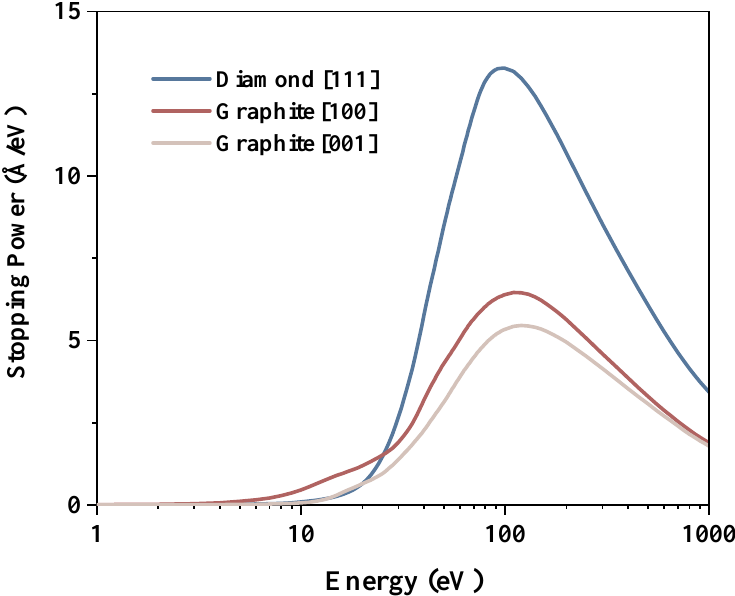
Figure 5. Stopping power for the [111] direction of diamonds and the [100] and [001] directions of